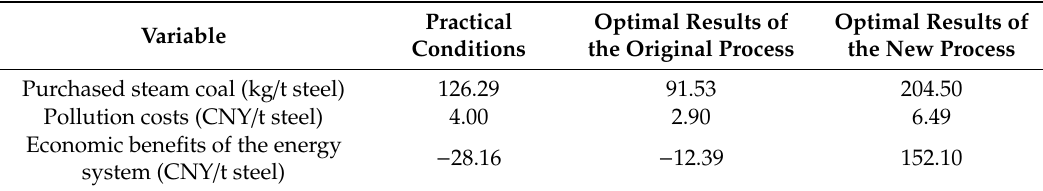
Table 5. Comparison between the model optimization results and practical conditions of the economic benefits of the energy